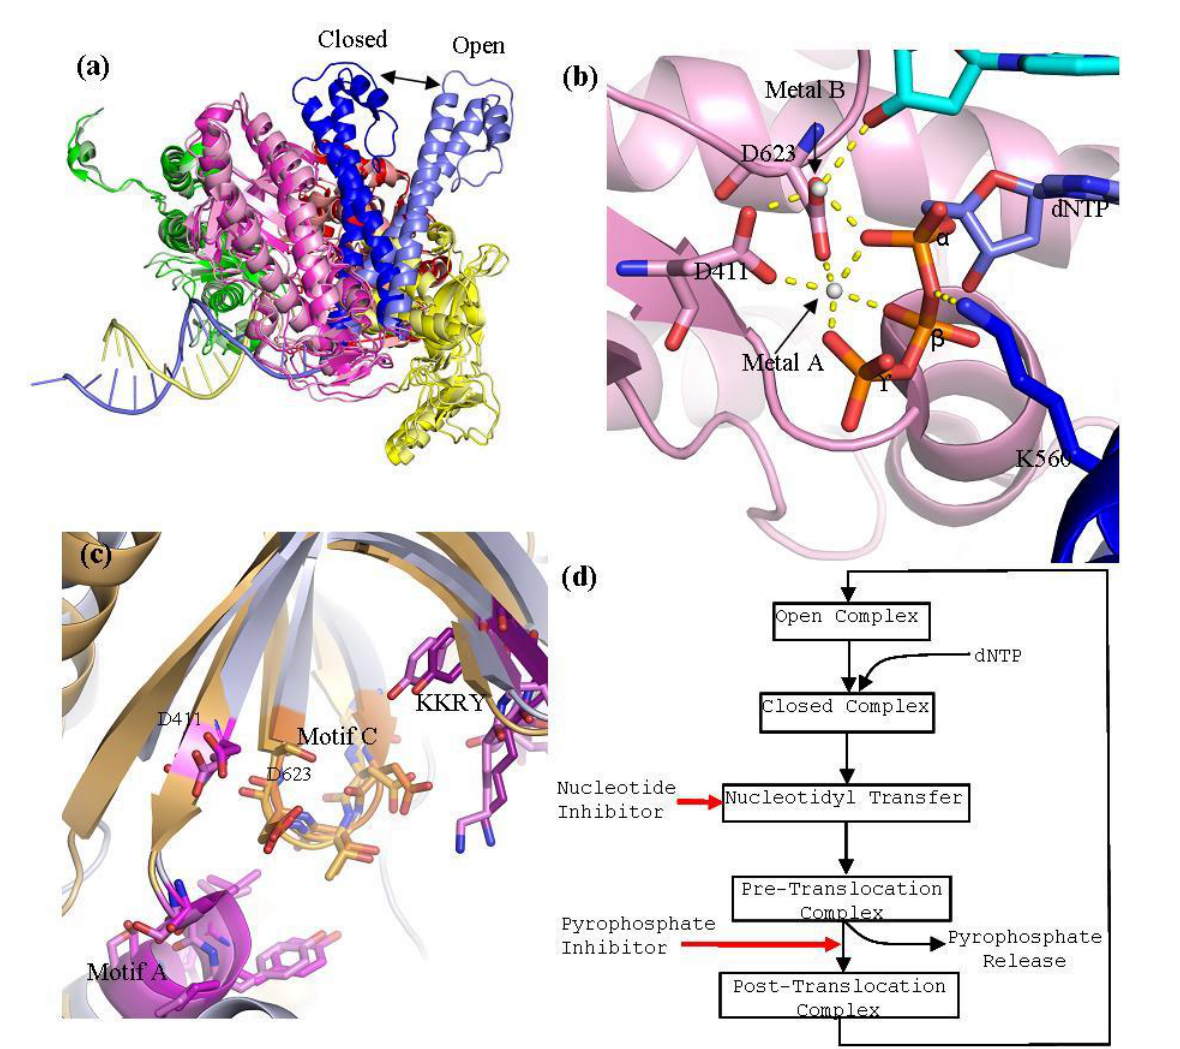
Figure 3. ( a ) Superpositioning of open and closed structures of RB69 gp43 showing finger domain movement. This diagram is composed of RB69 gp43 in the fingers closed position (pdb 3LDS) [37] and in the fingers opened position (pdb 1IH7) [15]. ( b ) Polymerase active site of RB69 gp43 showing interactions between conserved residues of motif A and C, metal ions A and B and dNTP and interactions between K560 and dNTP. This image is an aligned composite image of pdb 3LDS [37] and 3SCX [38]. ( c ) Structural alignment of the polymerase active site of RB69gp43 (pdb 3LDS) and HSV1 UL30 (pdb 2GV9). RB69 gp43 backbone is in light blue while the HSV1 UL30 backbone is in light orange. Active site residues of RB69 gp43 are indicated. RB69 gp43 motif A is in magenta, motif C is in orange and KKRY is in purple. HSV1 UL30 motif A is in pink, motif C is in light orange and KKRY is in light purple. Images were generated using Pymol [23]. ( d ) Generalized diagram of the polymerase catalytic cycle showing steps at which inhibitors can act. Nucleotide inhibitors, once incorporated, prevent further extension of the DNA primer, by inhibiting nucleotidyl transfer. Whereas, pyrophosphate inhibitors mimicking the pyrophosphate leaving group, stabilizing the pre-translocation complex and prevent